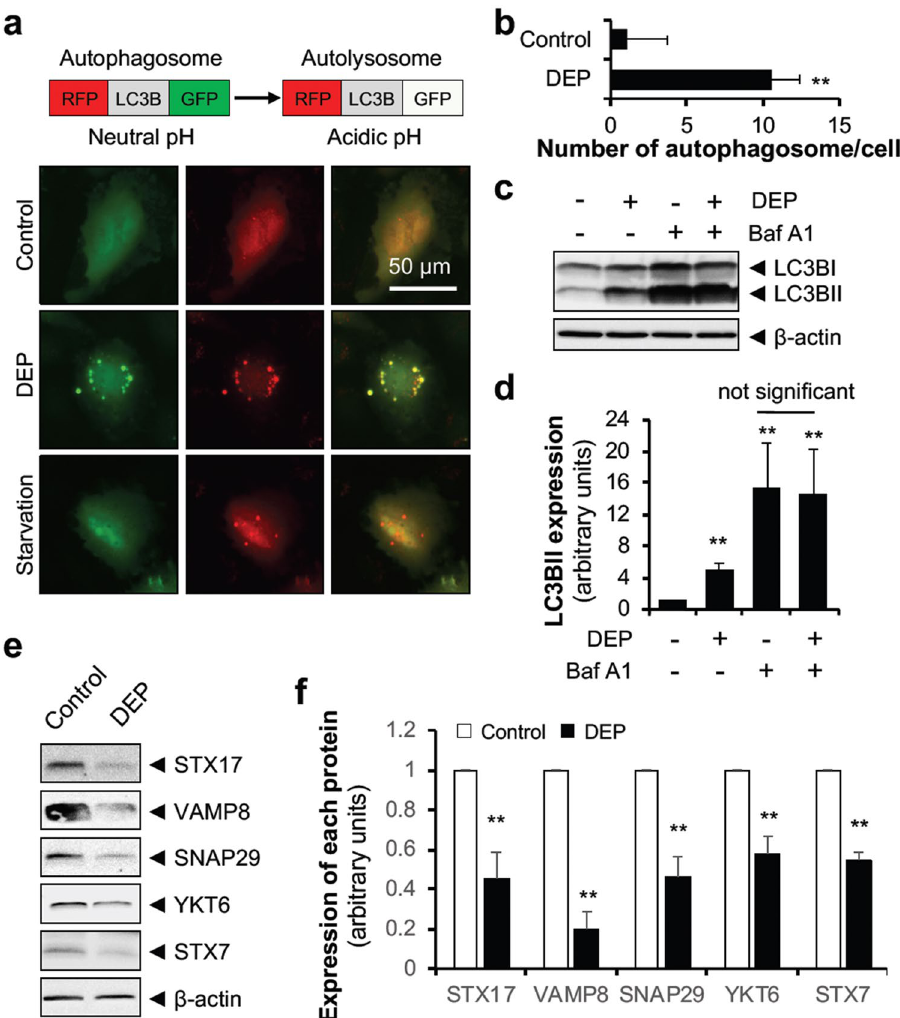
Figure 4. DEP impair autophagic flux in the degradation stage. ( a ) HUVECs infected with RFP-LC3B-GFP- expressing adenovirus were exposed to DEP (70 µg/ml) for 18 h and autolysosome formation was examined under fluorescence microscopy. ( b ) The number of yellow signals per cell was counted from 10 randomly selected cells. Statistical analysis was performed using two-tailed Student’s t test. **P < 0.02 versus control. ( c ) HUVECs were pre-incubated with Bafilomysin A1 (Baf A1, 100 nM) for 3 h and exposed to DEP (70 μg/ ml) for an additional 12 h. LC3B level was measured by immunoblotting. ( d ) Quantification of LC3BII levels normalized to β-actin. Results are presented as means ± SD ( n = 3). Statistical analysis was performed using one-way ANOVA. **P < 0.02 versus no treatment. ( e ) HUVECs were exposed to DEP (70 μg/ml) for 24 h and protein levels of STX17, VAMP8, SNAP29, YKT6, STX7, and β-actin were measured by immunoblotting. ( f ) Quantification of STX17, VAMP8, SNAP29, YKT6, and STX7 levels normalized to β-actin. Results are presented as means ± SD ( n = 3). Statistical analysis was performed using two-tailed Student’s t test. **P < 0.02 versus